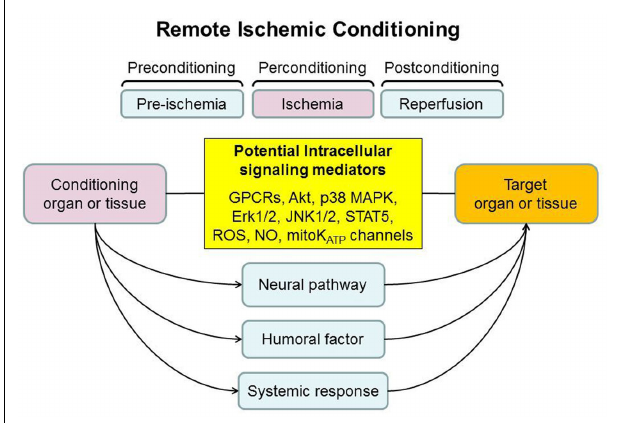
FIGURE 1 |The timing and the potential mechanisms underlying remote ischemic conditioning (RIC). The RIC stimulus can be applied prior to ischemia (preconditioning), after the onset of ischemia (perconditioning), or at the time of reperfusion (postconditioning). A variety of intracellular signaling mediators have been implicated in the protective effect of RIC.Three main mechanisms for transmitting the protective signal from the organ or tissue, in which the RIC stimulus is applied, to the target organ or tissue (these are not mutually exclusive): (1) neural pathway, (2) the release of circulating humoral factor(s), and (3) activation of a systemic protective effect (such as an anti-apoptotic or anti-inflammatory